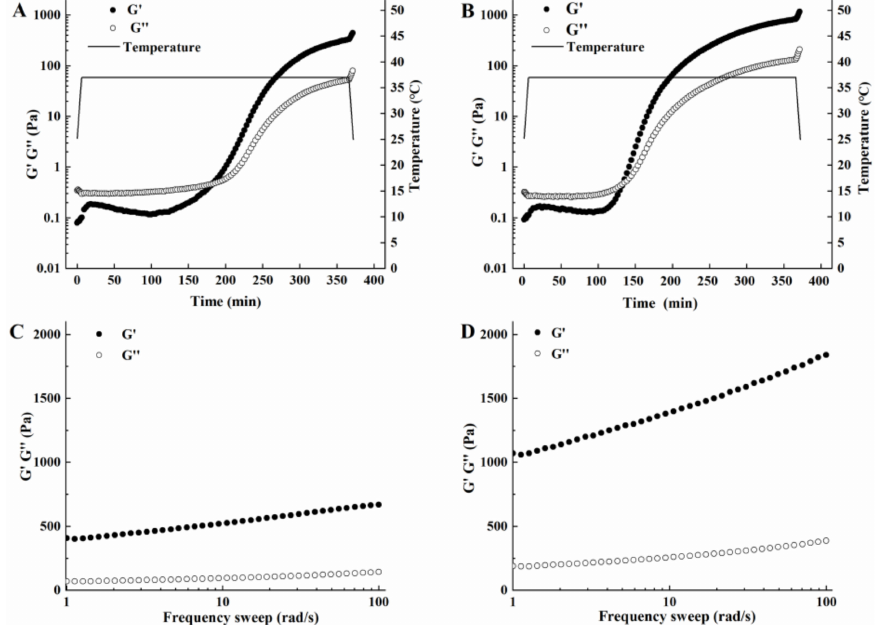
Figure 4. Time sweep G’ and G” of tofu gelatin induced by coagulants fermented by L. paracasei ( A ) and L. plantarum ( B ). Frequency sweep G’ and G” of tofu gelatin induced by coagulants fermented by L. paracasei ( C ) and L. plantarum ( D